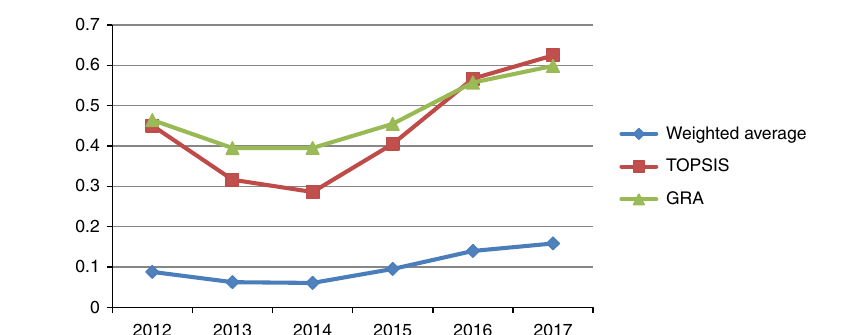
Table VIII. Evaluation results obtained by three different methods